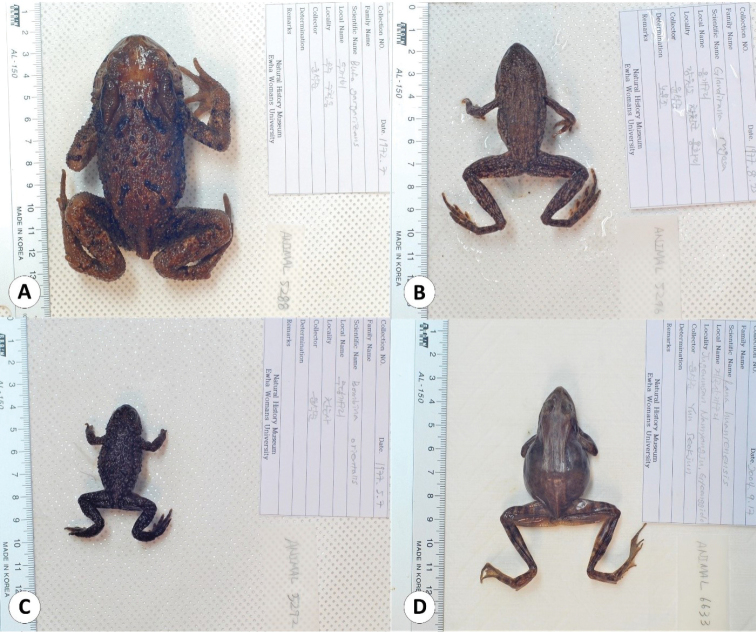
Some of the frog specimens deposited in the collection of the EWNHMABufo
gargarizans (EWNHM-ANIMAL 5288) BGlandirana
emeljanovi (EWNHM-ANIMAL 5296) CBombina
orientalis (EWNHM-ANIMAL 5292) DRana
huanrenensis (EWNHM-ANIMAL 6633).